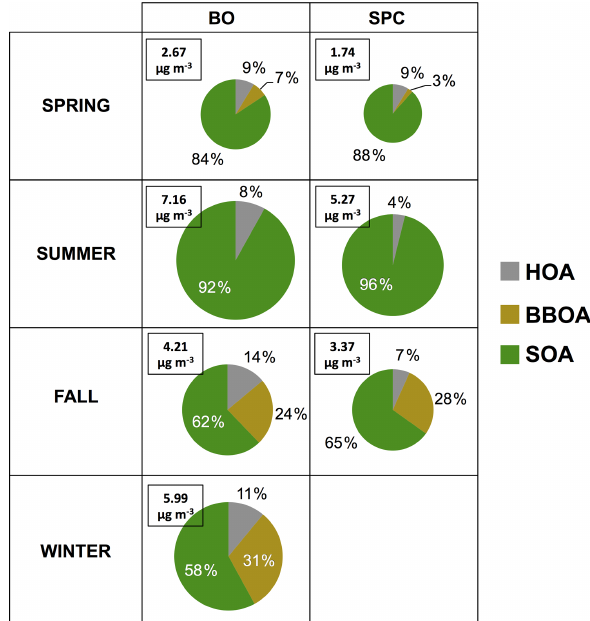
Figure 6. Seasonal relative contribution of the main OA sources at both the urban and rural sites. The pie-chart area is proportional to the total average concentration of OA (shown on the upper-left side of each box in terms of µgm − 3 ) and the individual portions are the averages between the different campaigns made at the sites in one